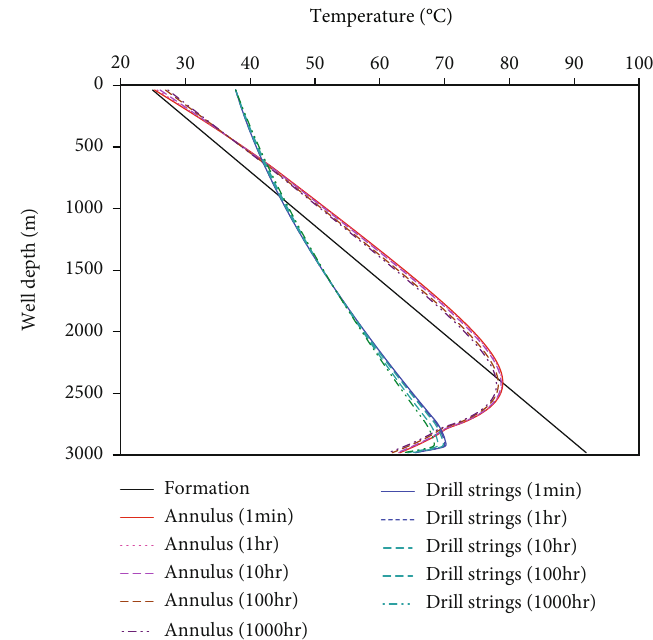
Figure 7: The temperature pro fi le of both annulus and the drillstrings at di ff erent circulating